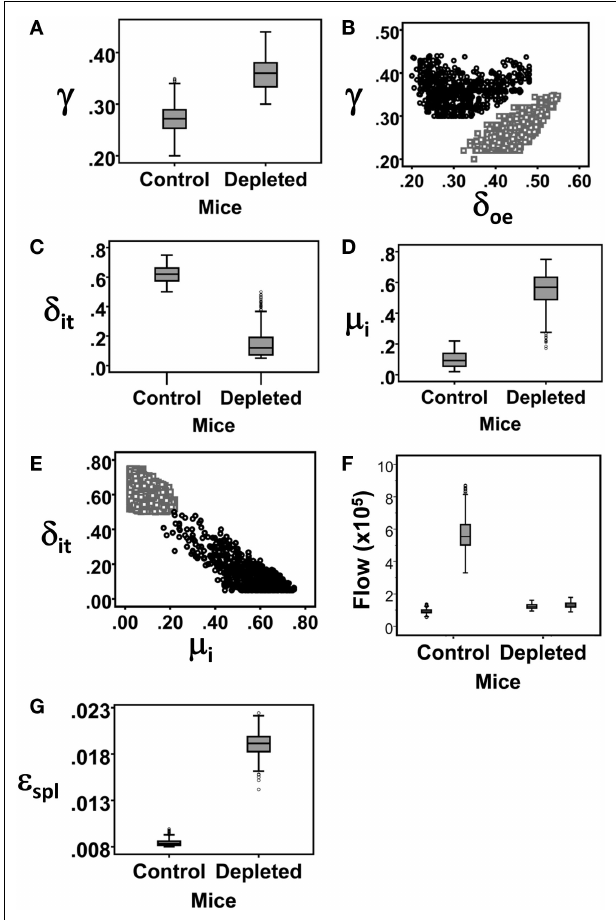
FIGURE 5 | Box Plots of the parameter value distributions for each rate parameter that was found to significantly differ between the simulations of control and depleted mice . (A) The proliferation rate of the B oe subpopulation. (B) The proliferation rate of the B oe subpopulation plotted against its differentiation rate. (C) The rate of exit of immature B cell from the BM. (D) Immature B cell death rate. (E) The rate of exit of immature B cell from the BM plotted against their death rate. (F) Box Plots of the sources of mature recirculating B cell subpopulations, that is, the total cell number entering in each time step of 6h. The white boxes are the flows from the splenic mature B cell subpopulation ( φ s (cid:2) B Mspl ) and the gray boxes are the flows from the BM immature B cell subpopulation ( δ i_re (cid:2) B i ). (G) The exit rate from the splenic mature B cell